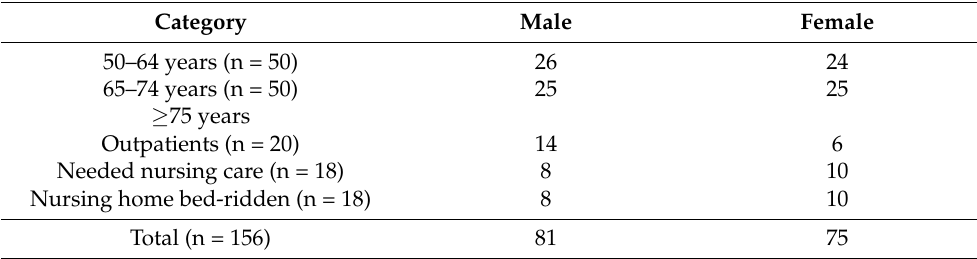
Table 1. Number of subjects in separate